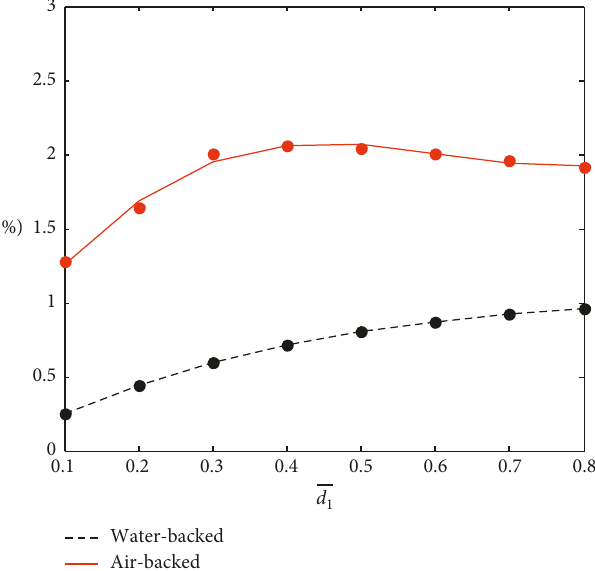
Figure 18: The transmission coefficients of peak pressure for different outer shell thicknesses. The water-backed case is plotted in the left axis, and the air-backed case is plotted in the right axis.